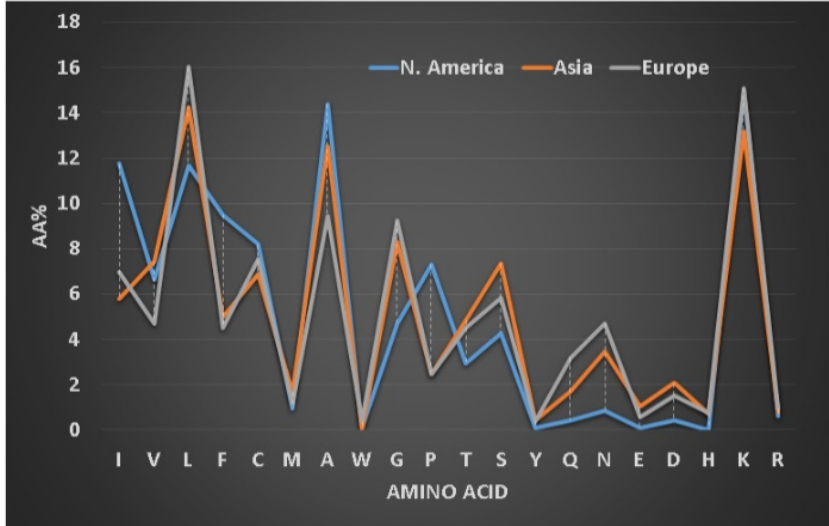
Figure 3. Variation in the amino acid signatures of brevinin peptides discovered in three regions: 152 from Asia, 20 from Europe and 48 from North America. The dotted vertical line indicates the maximal difference between two groups. Data from the APD as of June 2020 [78].